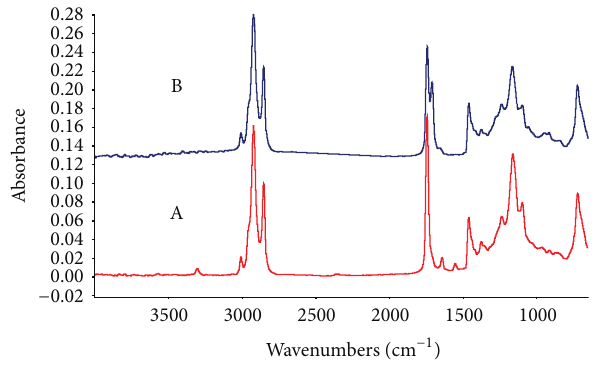
Figure 1: FTIR spectra of commercial N. sativa oil (A) and freshly extracted oil from N. Sativa seed